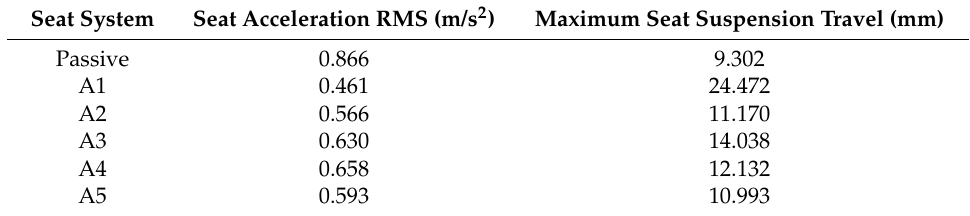
Figure 20. Health risk assessment, according to ISO 2361-1, of the proposed active seat suspensions and passive system under different vehicle speeds (km/h). ( a ) 40; ( b ) 60; ( c ) 80; ( d ) 100. Table 6. Time response characteristics of the proposed controllers under a bump road